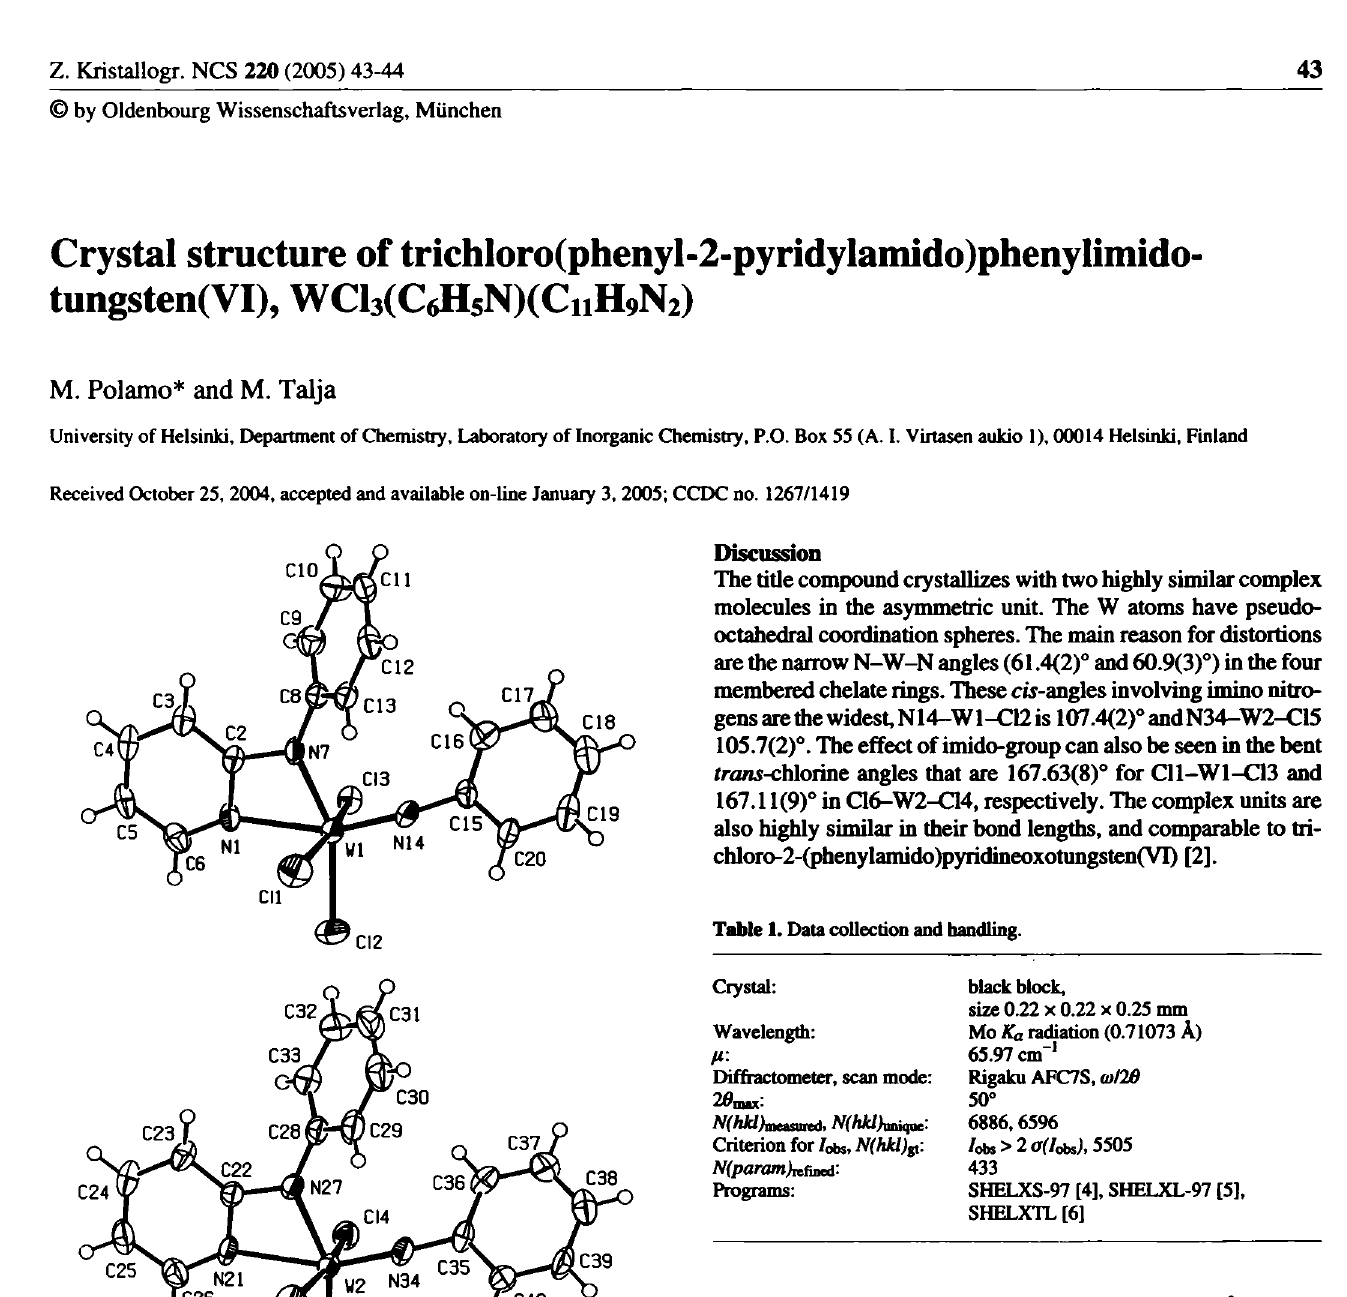
Table 2. Atomic coordinates and displacement parameters (in A 2